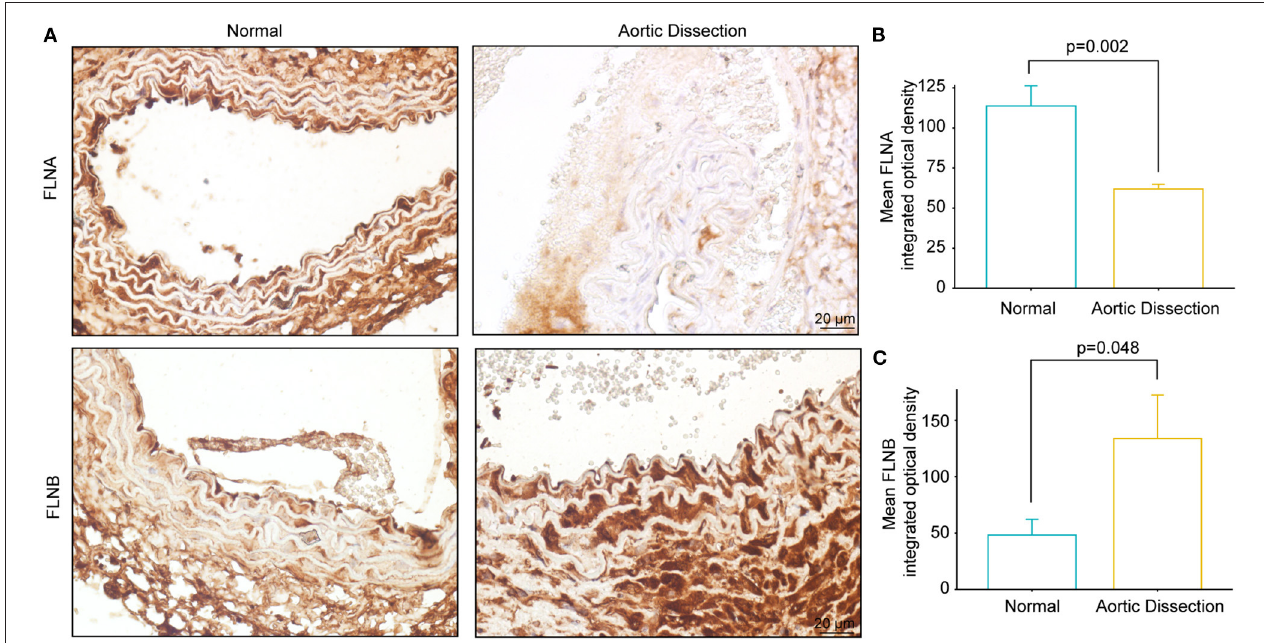
FIGURE 7 | The expression of FLNA and FLNB in mice with AD is similar to that in human tissue. (A–C) Representative images of immunohistochemical staining and quantitative results of FLNA and FLNB in the aorta sections of the normal and BAPN-induced AD mice ( n =